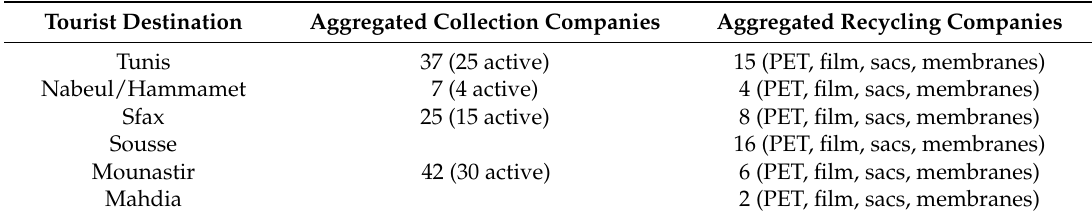
Table 5. Existing collection and recycling companies in six tourist destinations (source: National Agency of Waste Management